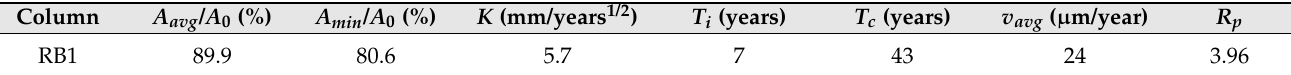
Figure 11. RC beam from the car park after concrete cover removal ( a ); details of the bar as extracted ( b ) and by tomographic scan ( c ). Table 8. Bar’s average and minimum residual cross-section, with respect to the original one, and corrosion attack characteristics estimated by processing the results of tomographic scans of bar RB1 .